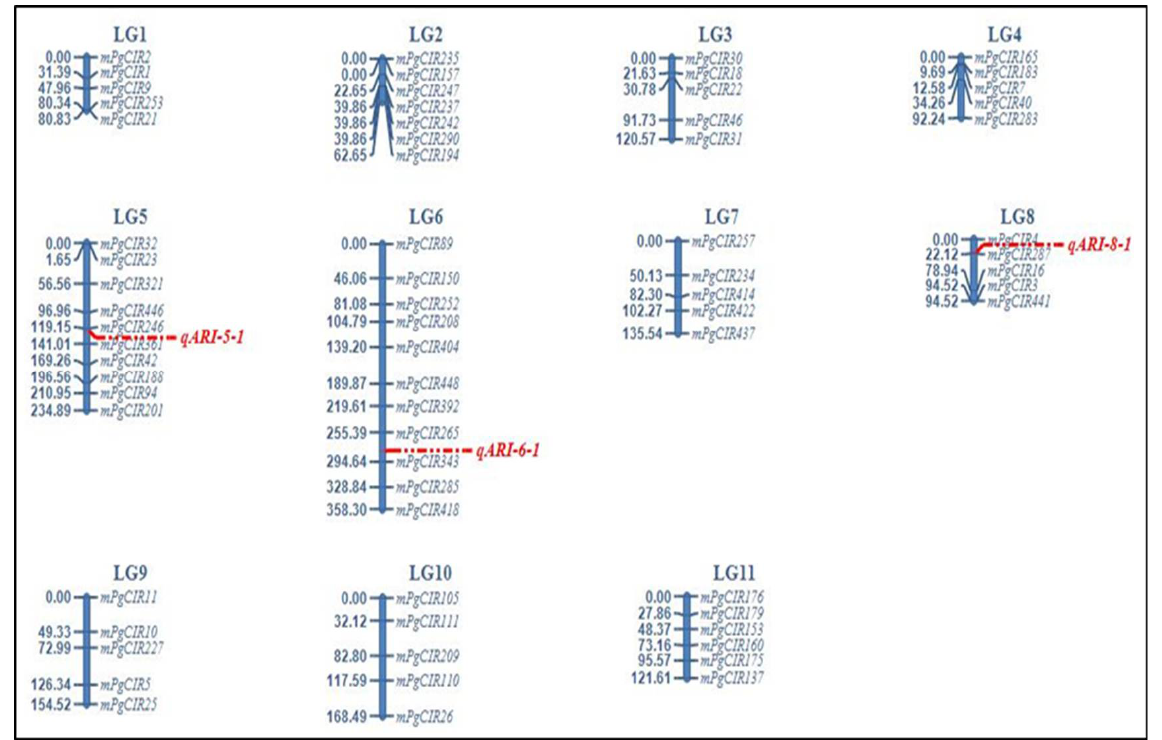
Figure 4. SSR-based linkage map of guava (AS × PG), and distribution of QTLs controlling antho- cyanin trait.